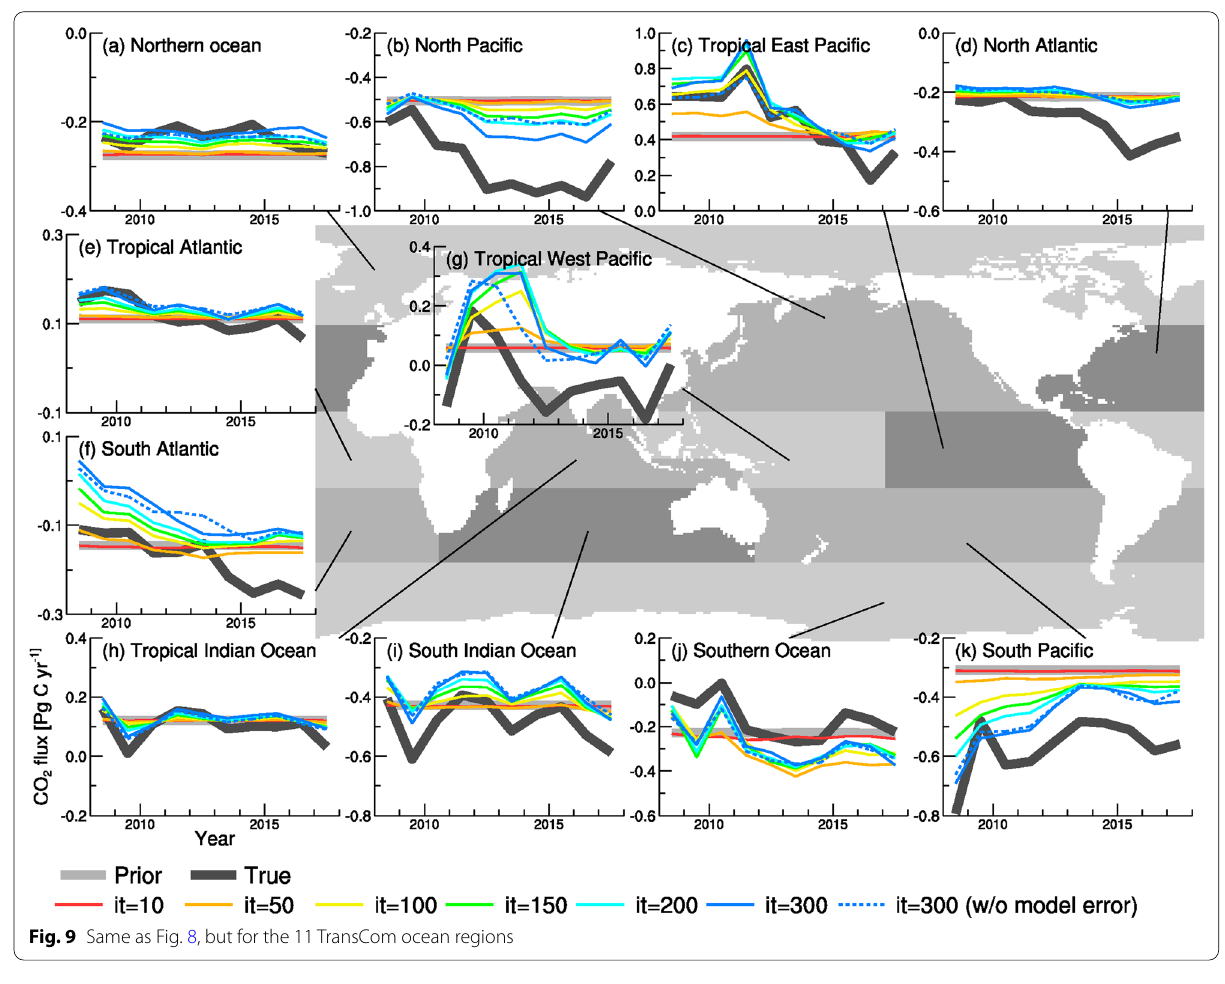
Fig. 9 Same as Fig. 8, but for the 11 TransCom ocean regions